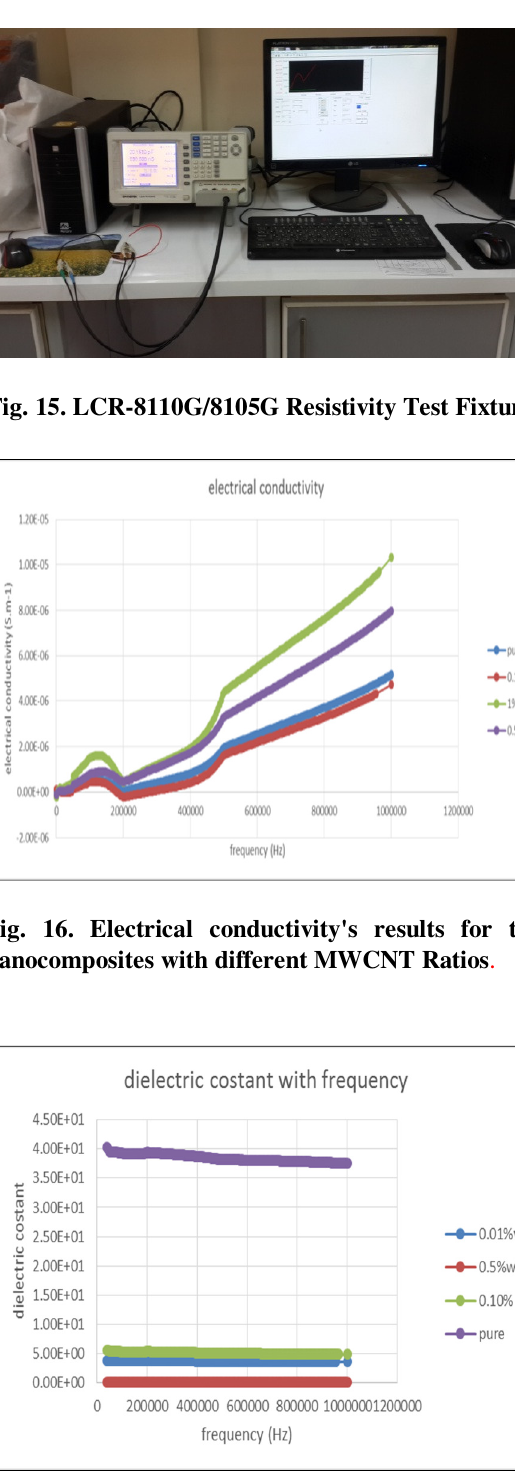
Fig. 17. Dielectrically constant's resultsfor the nanocomposites with different MWCNT